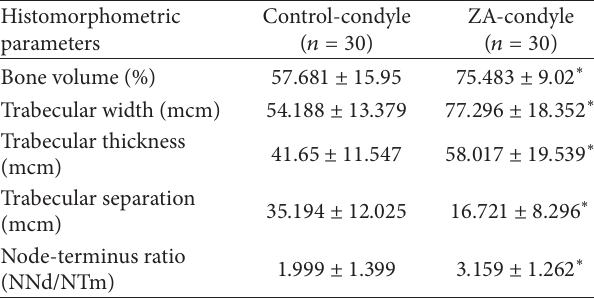
Table 2: Comparison of the histomorphometric